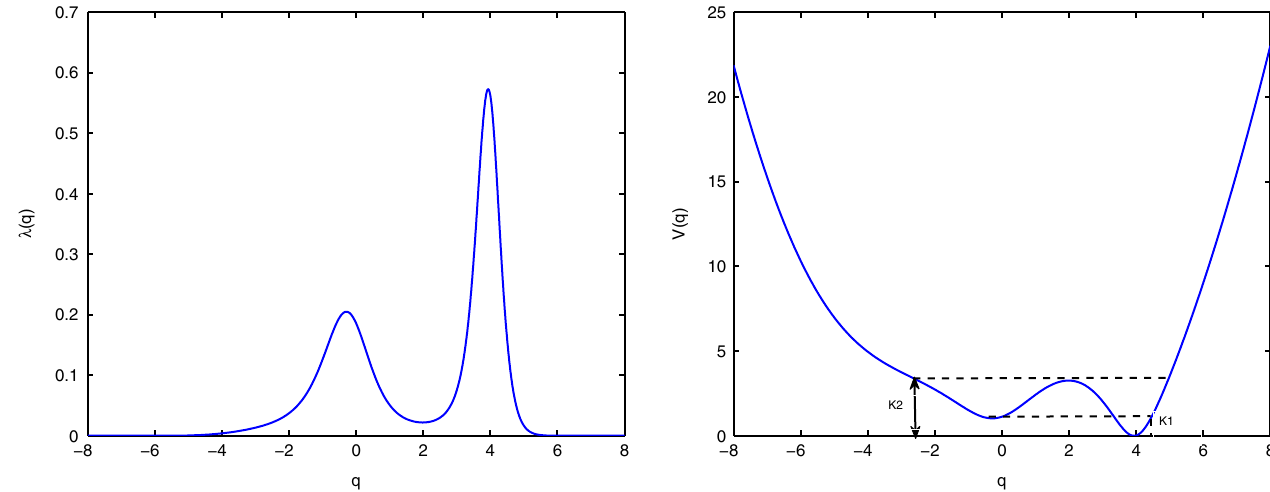
FIG. 10. Double-peak distribution on the left and its corresponding double-well potential on the right for the Q ¼ 1 broadband resonance model with (cid:7)